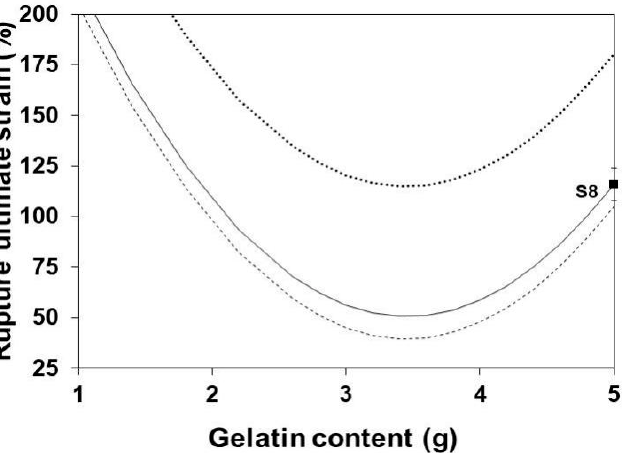
Figure 8. Effect of gelatin content on the RUS of SLGMs, varying the plasticizer content: 1.0 mL (continuous), 2.5 mL (dashed) and 5.0 mL (dotted). Experimental point: S8. Conditions: water content = 50 mL; maturation time = 7.5 min.